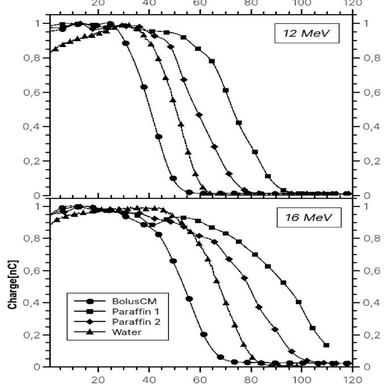
Measured depth dose curves for 6 and 9 MeV electron beams measured for Water and BolusCM, paraffins 1 and 2 boluses.